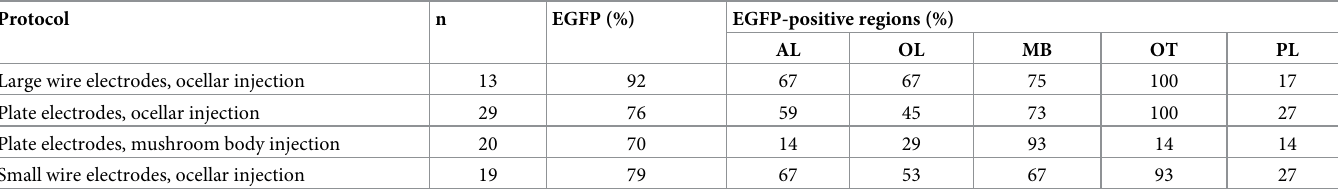
Table 3. EGFP distribution 3 days after electroporation (200–300 V/cm). Protocol